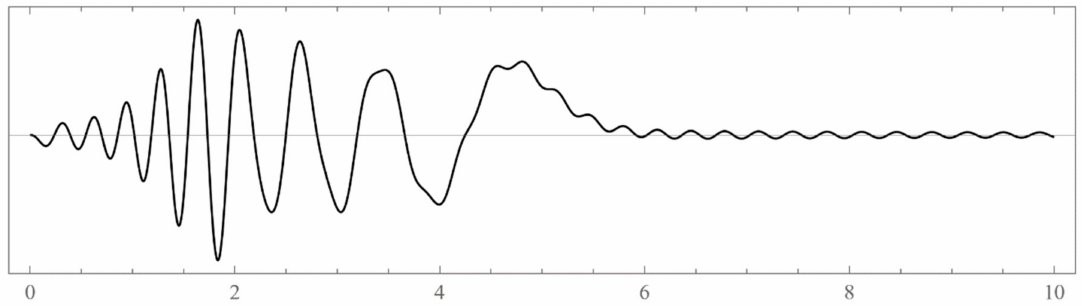
Figure A22. The un-normalized wavefunction (cid:101) ψ ( r , E ) for N = 100. We took E = 150 λ 2 , for µ = − 15, γ = 16, and ν = 2. We can see the bounded oscillations that extends to